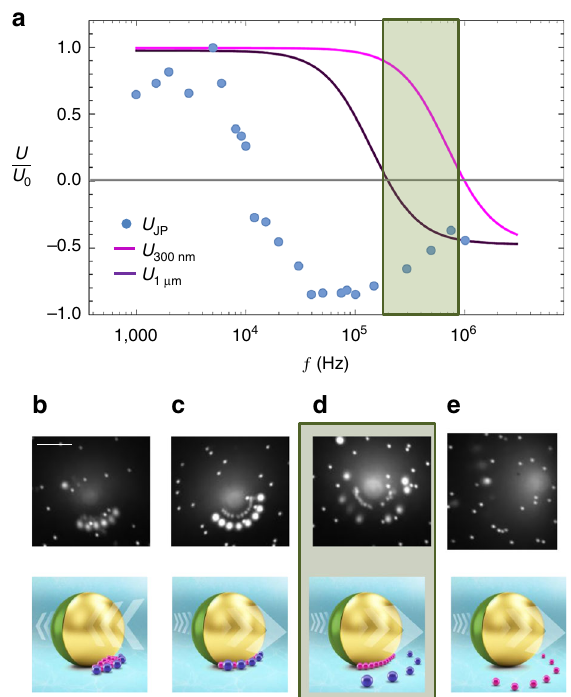
Fig. 4 Selective cargo assembly and transport. a Precise control of the frequency of the applied fi eld enables selective transport (green highlighted region). The desired operating frequency is chosen to align with positive DEP of target (magenta) and negative DEP of the contaminant (purple). The frequency of the applied fi eld also determines the mode of transport — whether by ICEP with Ps hemisphere forwards or sDEP with metallic hemisphere forwards. Operating conditions can be determined by plotting the frequency-dependent mobility (particle velocity normalized by the maximum attainable value U 0 = 2.4 μ m s − 1 ) JP carrier (blue data points) and the real part of the Clausius – Mossotti factor of target and contaminant (magenta and purple curves). Four frequency domains are observed — each of which correspond with microscope images and schematics in b – e . b At low frequencies, target and contaminant undergo pDEP (non-selective trapping), whereas JP translates forward under ICEP. c Janus particle reverses direction but both target and contaminant still undergo pDEP. d Selective trapping — target undergoes pDEP, while contaminant undergoes nDEP. e Frequency aligned with nDEP of target for release. Scale bar in b